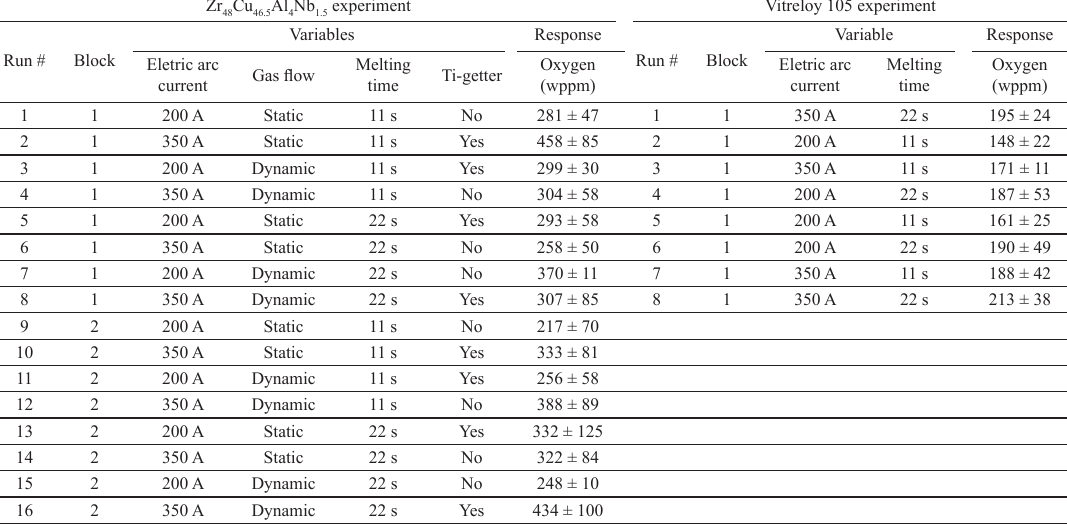
Cu Al Nb and Vitreloy 105 48 46.5 4 1.5